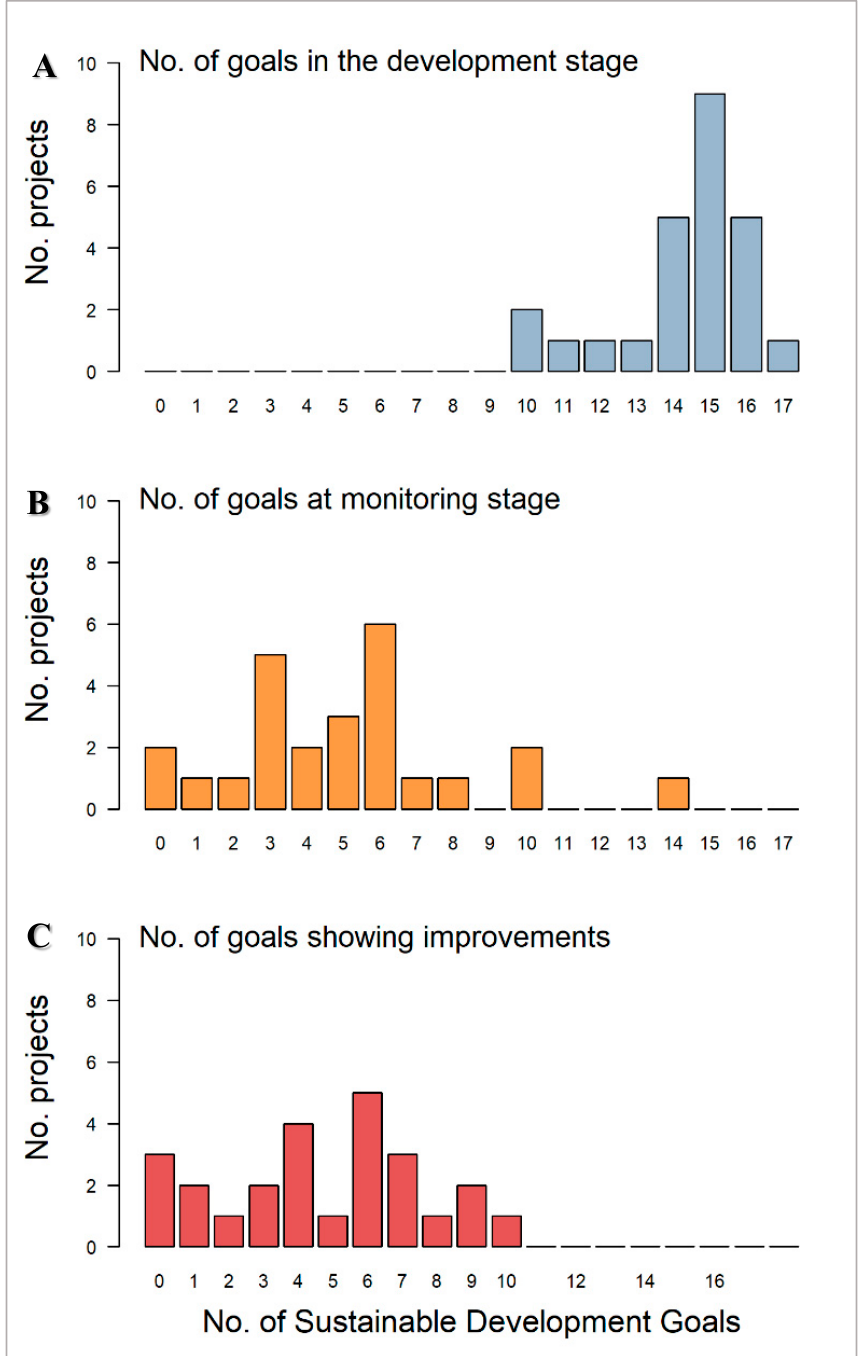
Figure 4. The number of Sustainable Development Goals that are being ( A ) aspired to in project design documents, ( B ) are being monitored or have monitoring variables identified in project implementation reports (no improvement yet), and ( C ) monitored and improvement is clearly demonstrable in project implementation reports, by the 25 reviewed REDD+ projects.